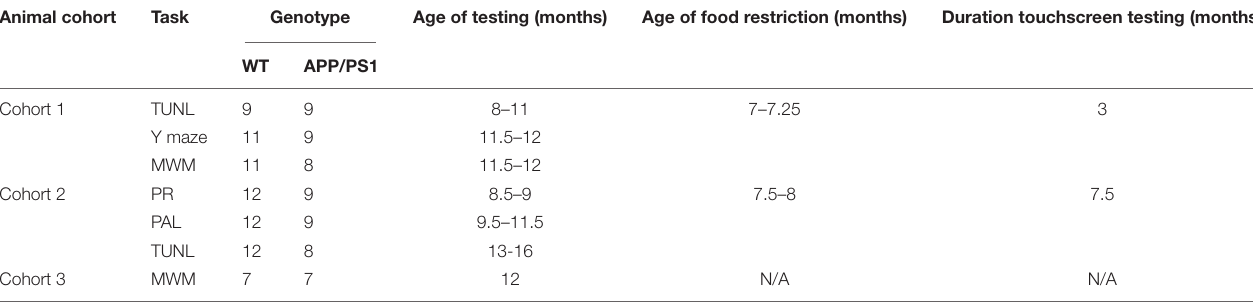
TABLE 1 | Numbers and ages of WT and APP/PS1 animals in each behavioral task.